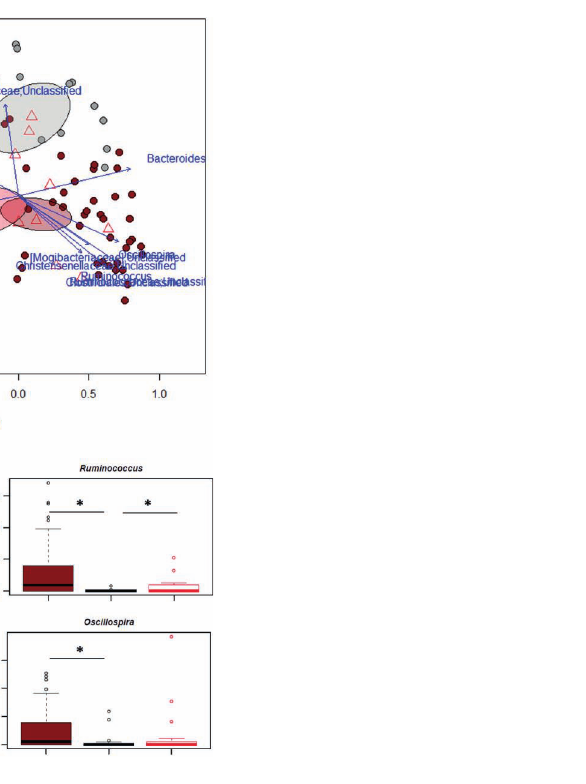
FIGURE 5 | The gut microbiota dysbiosis of COVID-19 patients is distinct from that of critically ill non-COVID-19 patients. (A) , Left, Alpha diversity estimated according to the inverse Simpson index, for COVID-19 patients admitted or not to ICU and other critically ill patients admitted to ICU just before the COVID-19 outbreak. A signi fi cant reduction was observed in all patients admitted to ICU regardless of the underlying disease (p value = 0.0003, Kruskal-Wallis test). Right, Principal Coordinates Analysis (PCoA) based on Bray-Curtis dissimilarity between the genus-level pro fi les. A signi fi cant separation was found among the study groups (p value = 0.001, permutation test with pseudo-F ratio). Ellipses include 95% con fi dence area based on the standard error of the weighted average of sample coordinates. Bacterial genera with the largest contribution to the ordination space are indicated with blue arrows (p value ≤ 0.001, permutational correlation test, “ env fi t ” function). (B) , Boxplots showing the relative abundance distribution of genera differentially represented between groups. *p value ≤ 0.05; **p value < 0.01; Wilcoxon